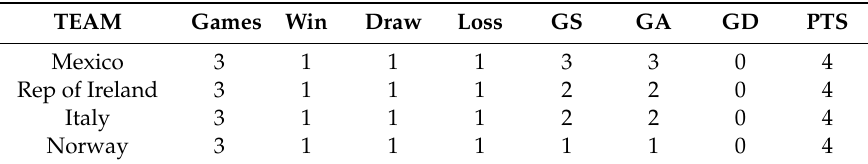
Table 1. FIFA 1994 World Cup Group E Final Standings [4]. TEAM Games Win Draw Loss GS GA GD PTS Mexico